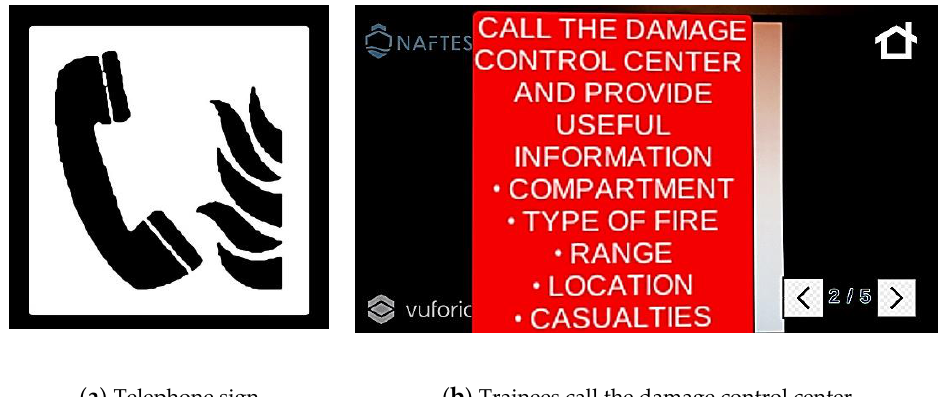
Figure 2. Second screen of a scenario of fire on an electrical circuit. ( a ) Printed target sign, and ( b ) the corresponding instructions that appear in the firefighters’ view.